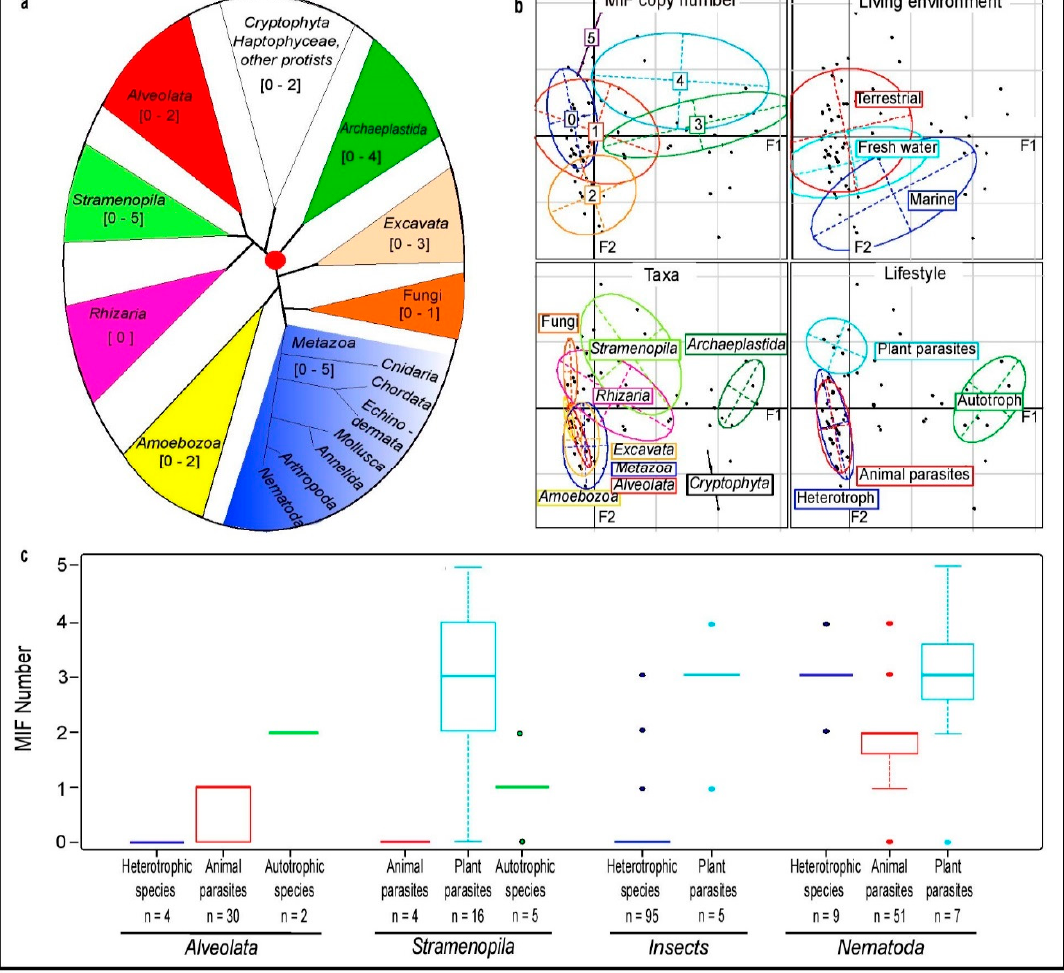
Figure 1. Analysis of MIF distribution across eukaryotic kingdoms. ( a ) Rooted phylogenetic tree of eukaryotic kingdoms according to Burki et al., 2014. The size of the triangle areas representing collapsed clades is not proportional to the number of taxa within each clade. The range of MIF sequence number identified in the respective species is indicated within square brackets. ( b ) Graphical representation of Multiple Correspondence Analysis (MCA) data showing, respectively, the distribution of MIF number, the environment, major taxa, and lifestyle. The confidence ellipses delimitate the centroid around each variable. The adjusted inertia of the F1 and F2 axes are 52.54% and 15.64% respectively. ( c ) Box plot analysis of MIF number according to the species lifestyle in Alveolata and Stramenopila , insects and nematodes ( n = number of species). The vertical axis corresponds to the number of unique MIF protein sequences per species. Each box is delimited by the quartiles Q1 and Q3, whose variation Q3–Q1 corresponds to 50% of the distribution. The horizontal line in the center of the box represents the median value. The two ends of the vertical bars correspond to the values of the first and last percentiles (C1 and C99) and delimitate 98% of the sample distribution. Extreme values (outliers) are indicated by a dot (below 2% of the sample distribution).